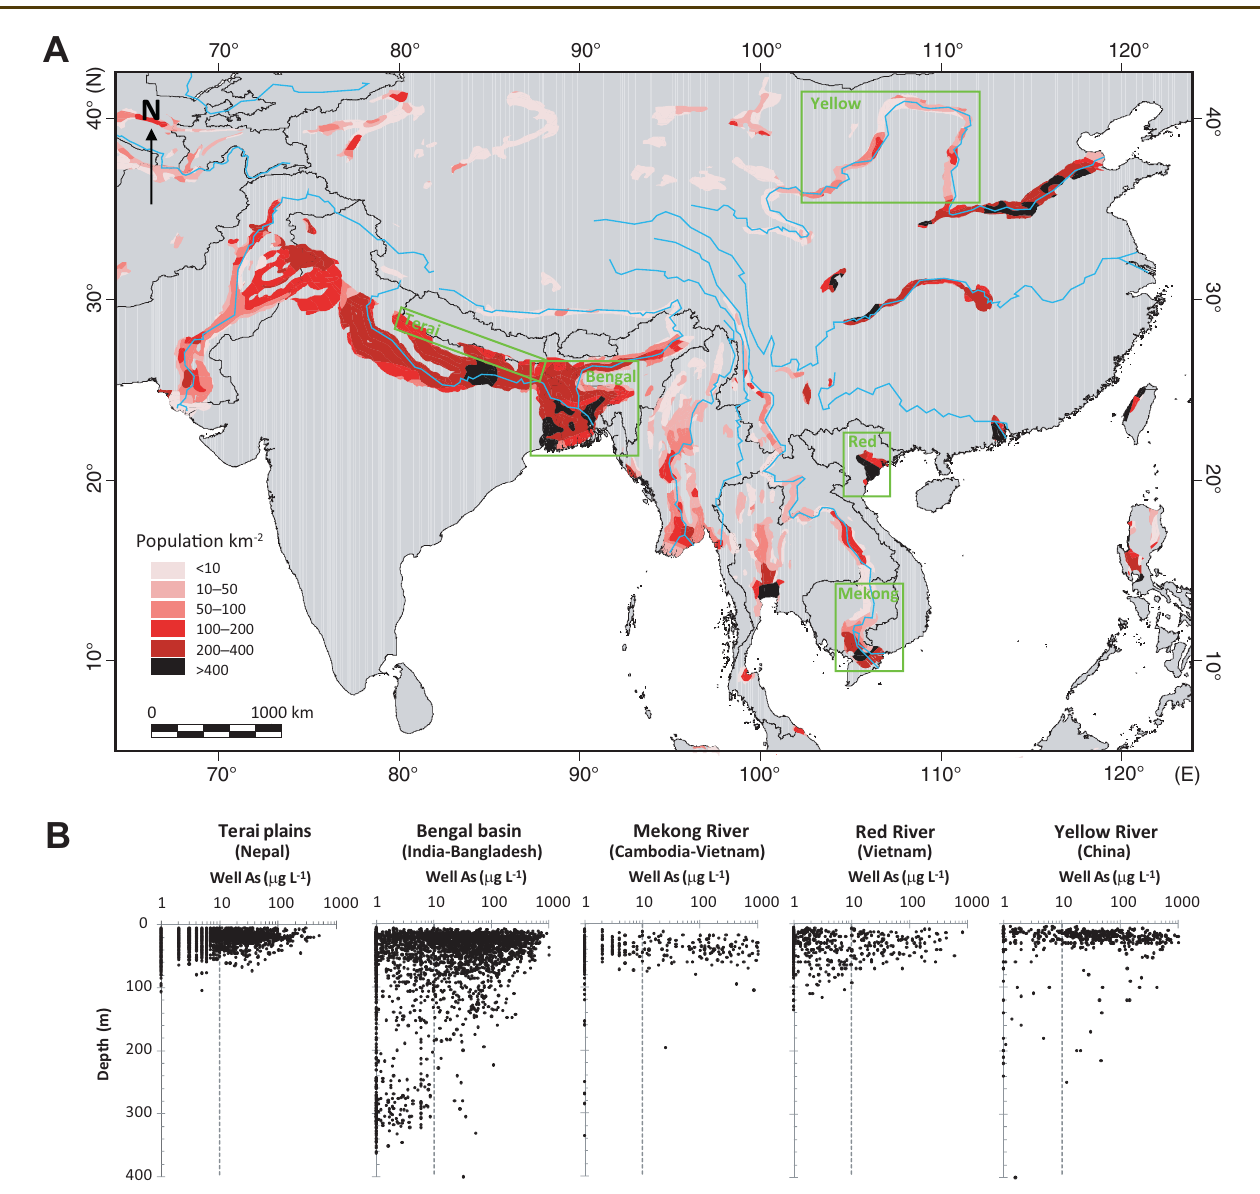
Figure 1. [A] Map of population density within regions where groundwater As concentrations are potentially elevated. [B] Geographic information system (GIS) files with population density from Ravenscroft (2007). Distribution of As in groundwater as a function of depth within five areas indicated by green rectangles in [A]. The vertical dashed line marks the WHO guideline of 10 μg L -1 . Sources include Kinniburg and Smedley (2001), Guo et al. (2003), Shrestha et al. (2004), Nickson et al. (2007), Buschmann et al. (2008), Guo et al. (2008), Deng et al. (2009), Gao et al. (2010), Han et al. (2010), and Winkel et al. (2011). These regions were outlined by considering a limited set of hydrogeological and climatic factors. Whereas groundwater contamination with As has been confirmed by actual measurements in many of the predicted regions, groundwater As concentrations have also been measured and found not to be elevated in some, including the lower reaches of the Yellow River in China and Chao Praya Delta in Thailand. In other areas such as the lower Mekong River, groundwater As levels may be elevated but the local population does not drink the water because it is affected by salt intrusion (Ravenscroft et al.,